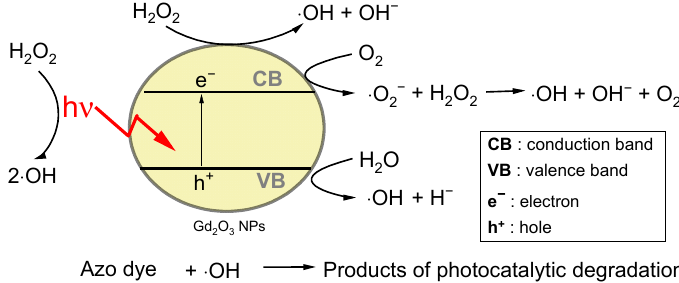
Figure 8. Mechanism of photocatalytic degradation of azo dyes by Gd 2 O 3 nanoparticles.